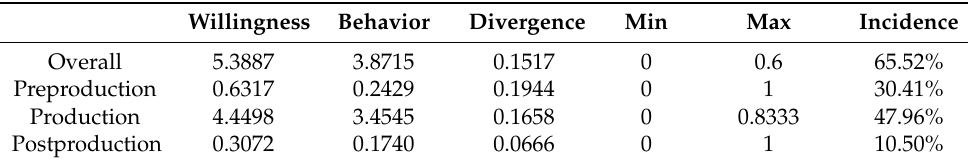
Table 2. Farmers’ willingness and behavior to purchase